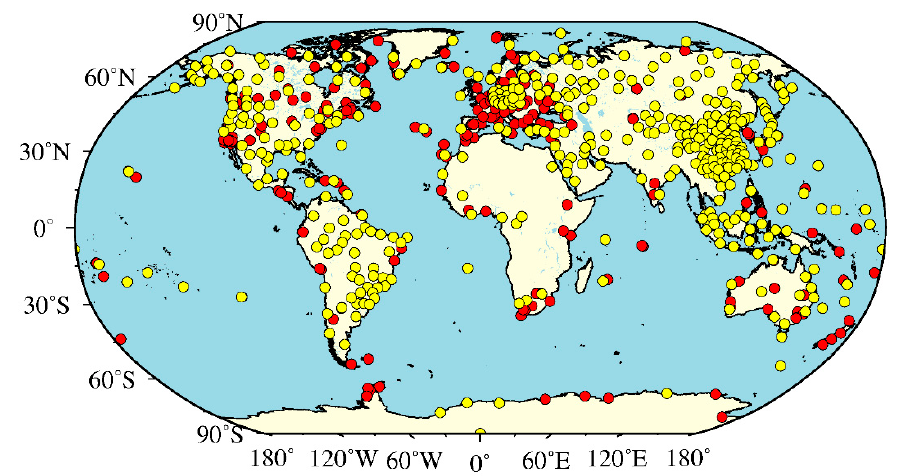
Figure 1. Distributions of the global International Global Navigation Satellite System (GNSS) Service (IGS) stations and radiosonde stations (red circles represent the IGS stations, and yellow circles represent the radiosonde stations).